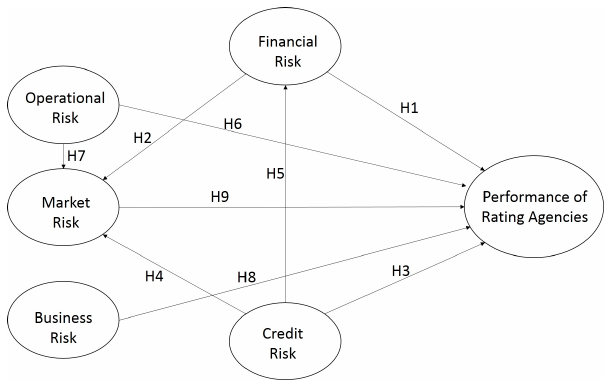
Figure 1. The Research Model.